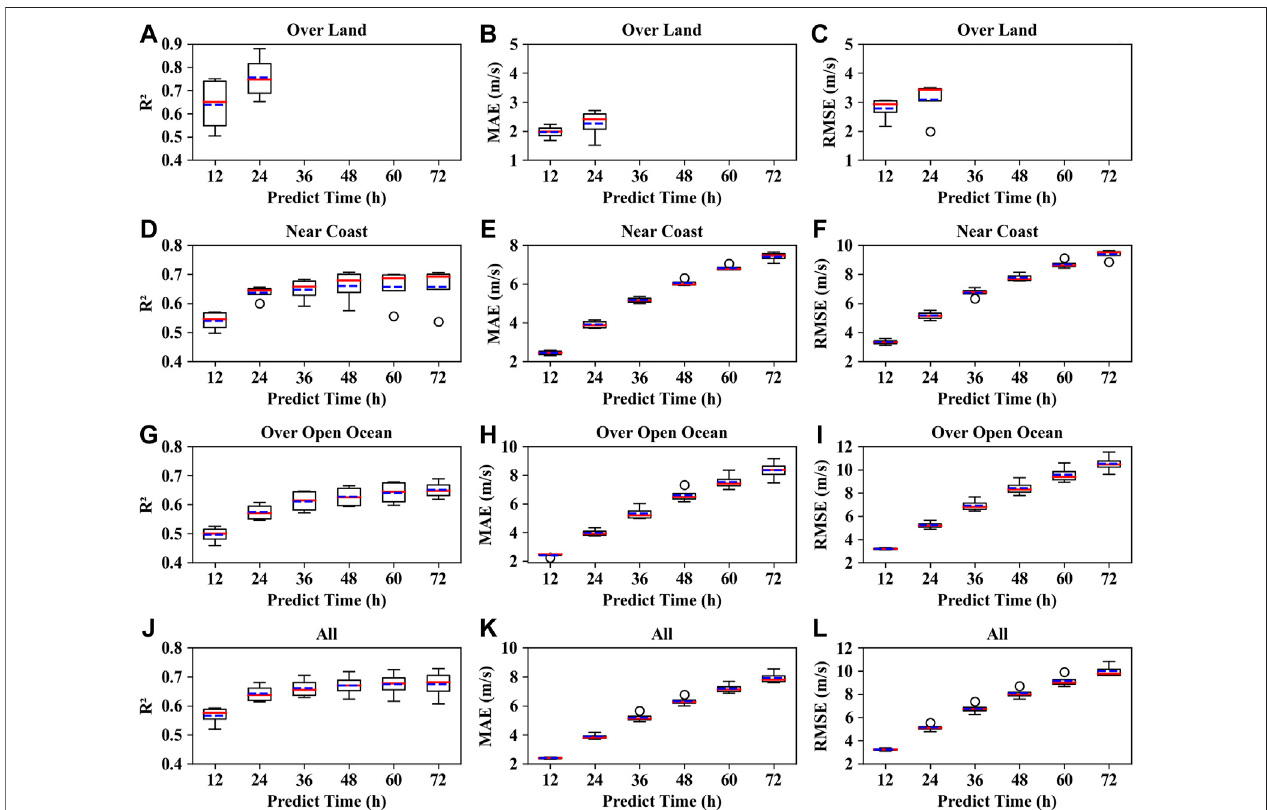
FIGURE4| EvaluationoftheperformanceoftheGBRTmodelinpredictingtheTCsfuture12-h,24-h,36-h,48-h,60-h,and72-hintensitychangeswithfourcross validations in terms of R 2 (the fi rst column), MAE (the second column), and RMSE (the third column) based on the STI TCs best track data. (A – C) for TC samples over land; (D – F) for TC samples near the coast; (G – I) for TC samples over the open ocean; (J – L) for all TC samples.